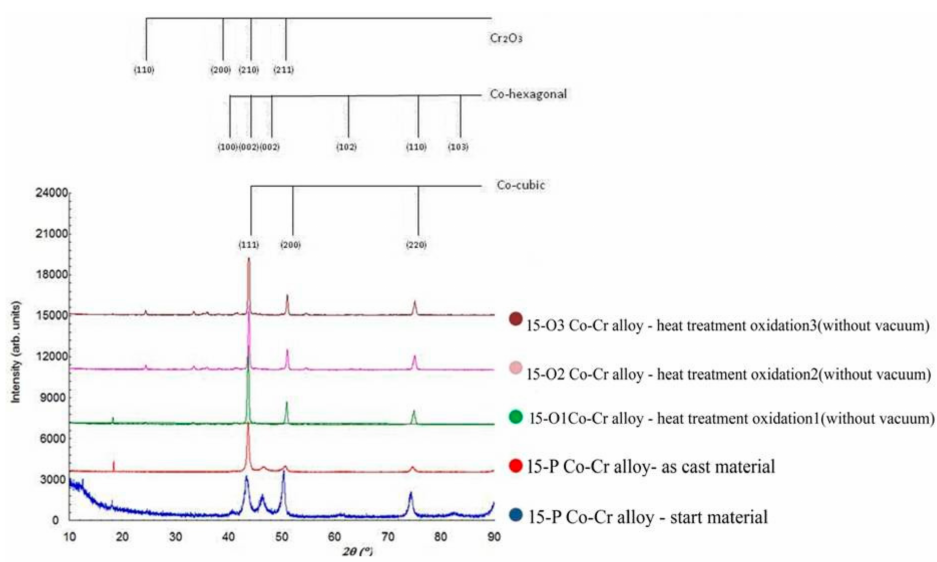
Figure 15. X-ray diffractograms for sample